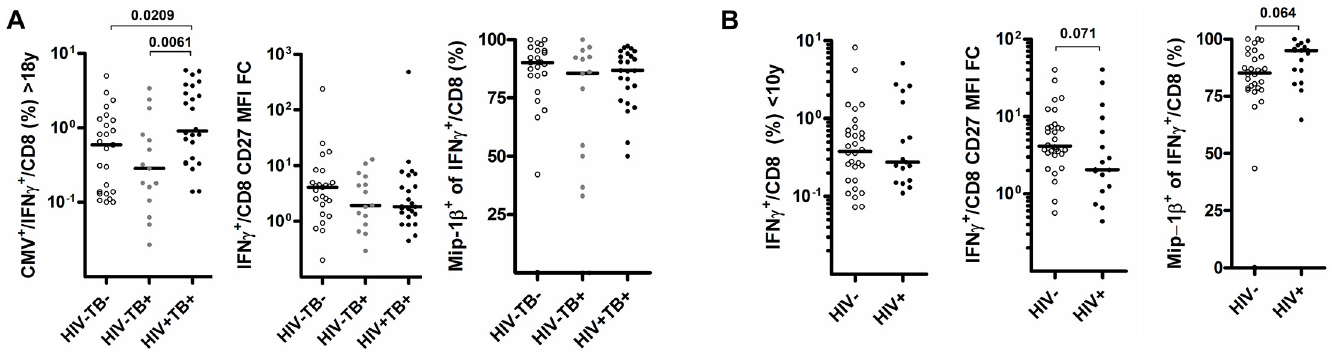
Fig 6. CD27 and Mip-1 β expression of CMV specific IFN γ producing CD8 T cell responses are not significantly influenced by HIV as well as tuberculosis co-infection in adults. Scatter-plots illustrating (A) the CD27 MFI fold-change to all CD8 + T cells and B) the proportion of cells producing Mip- 1 β of CMV specific IFN γ + -CD8 + T cell in patients under 10 or over 18 years old and according to HIV and TB infection status.